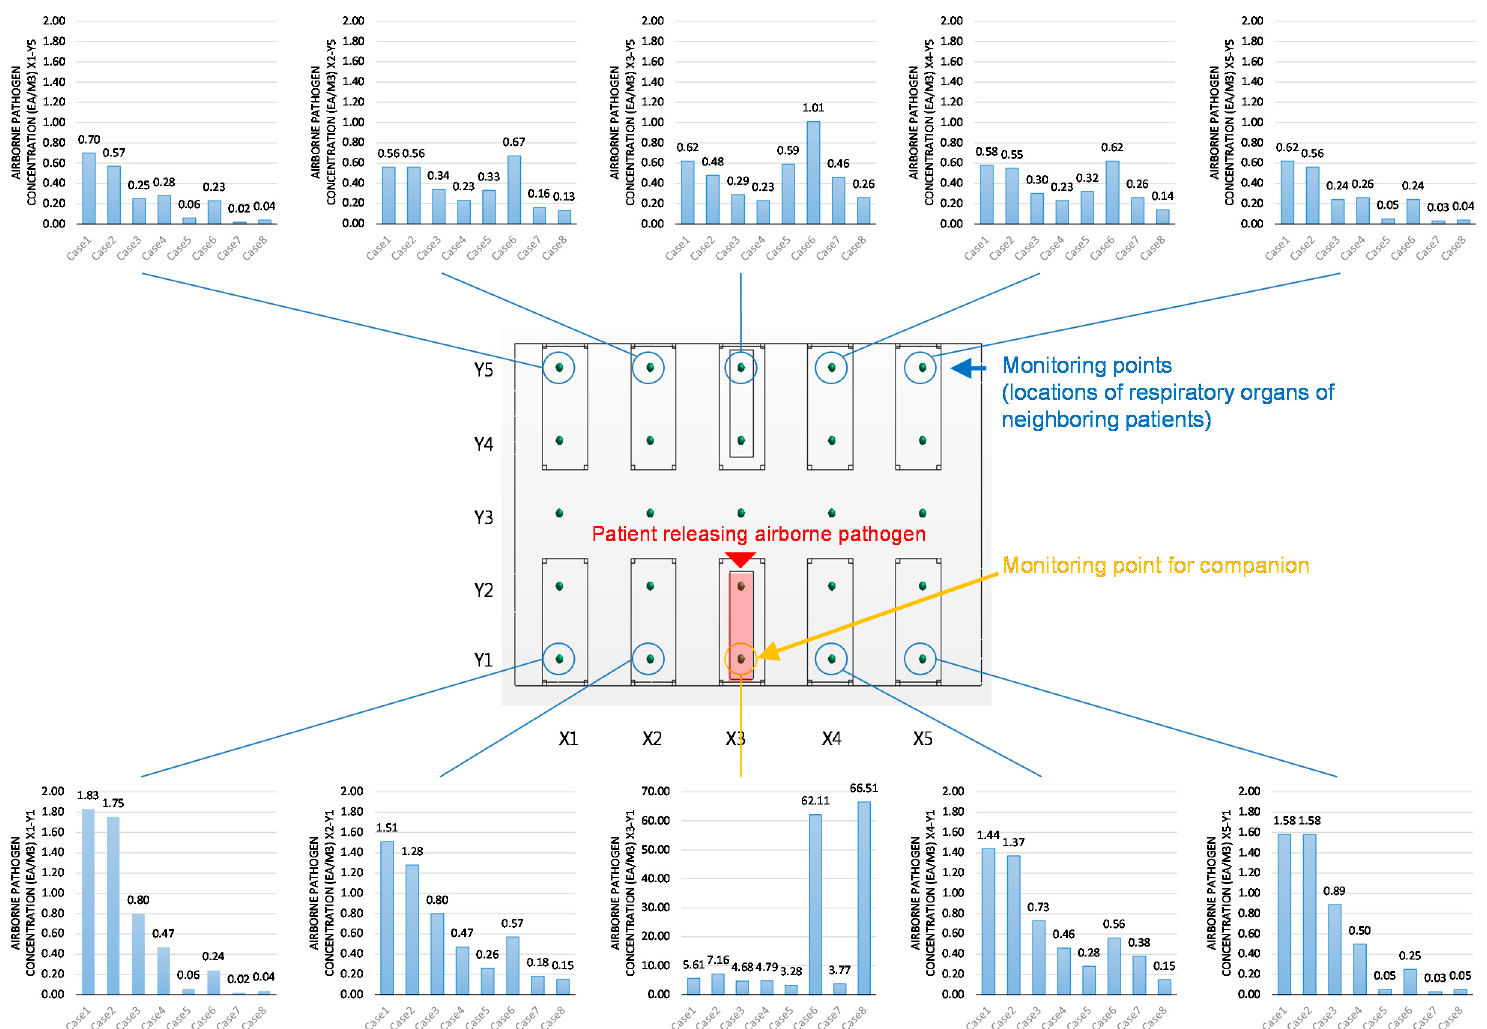
Figure 6. Average pathogen concentration for all cases.